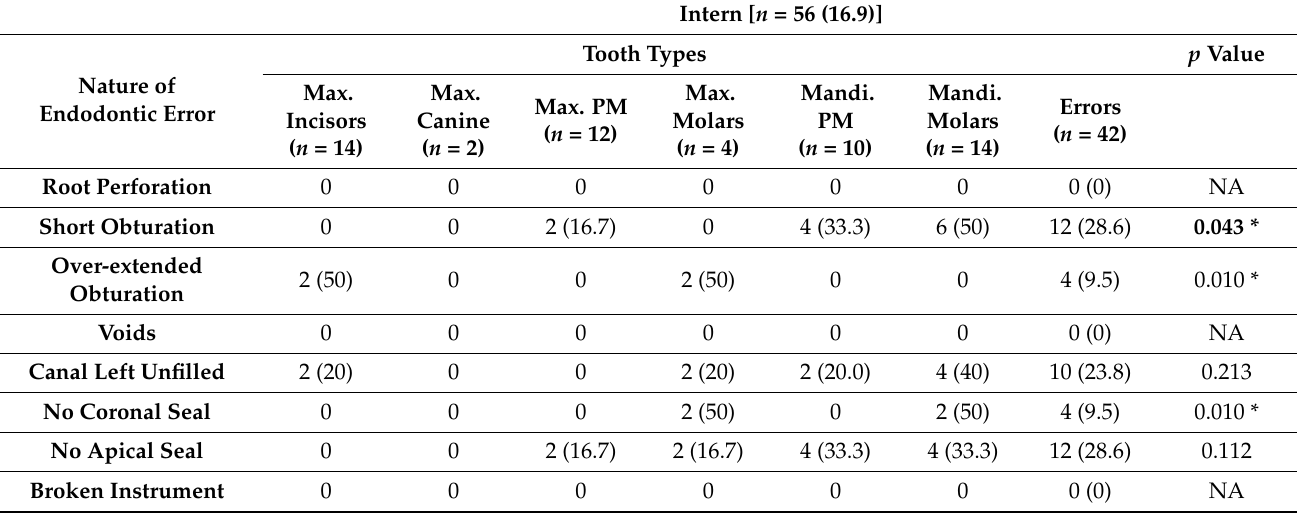
Table 5. The frequency and percentage of errors in RCF performed by interns according to various tooth